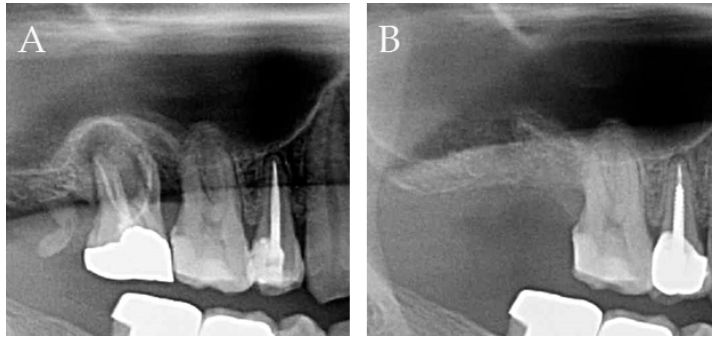
Figure 7. Alveolar ridge height preservation. ( A ) Preoperative. ( B ) Three months after extraction. Table 6. Variation in radiographic alveolar height by time of measurement. Time of Measurement Average Radiographic Change in Alveolar Bone Height (mm)